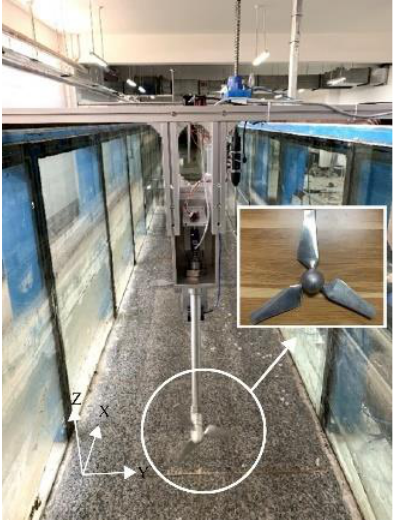
Figure 5. Layout of circulation pool and